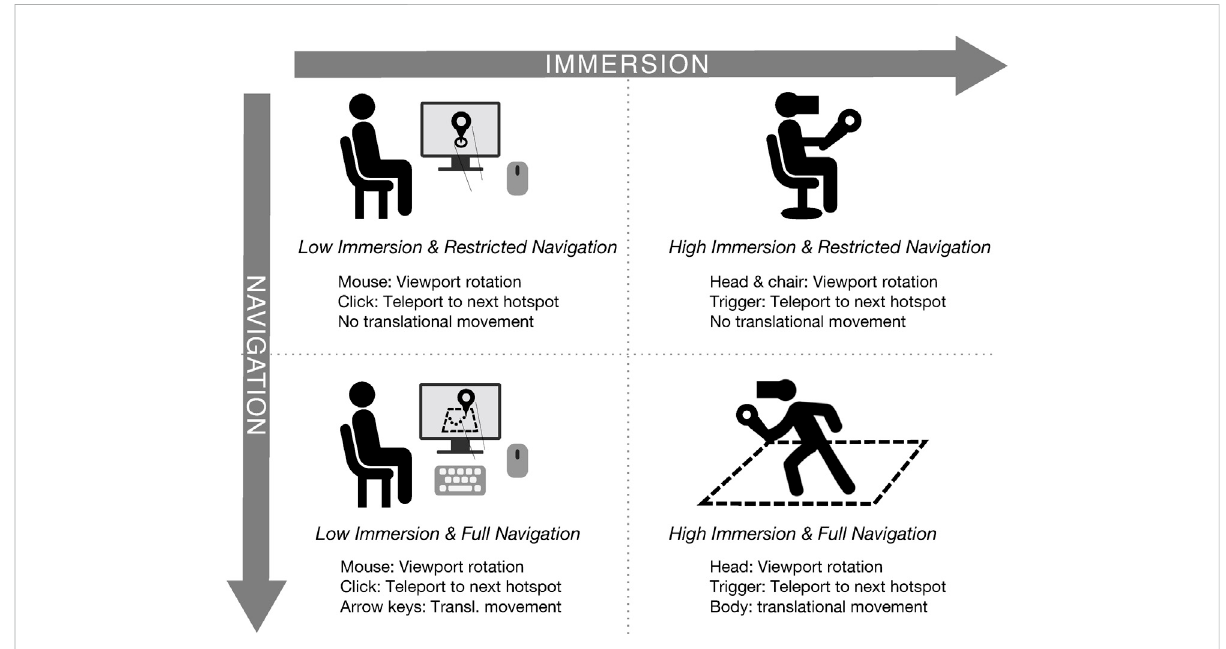
FIGURE 4 The four different experimental conditions we used in our two-factorial study.